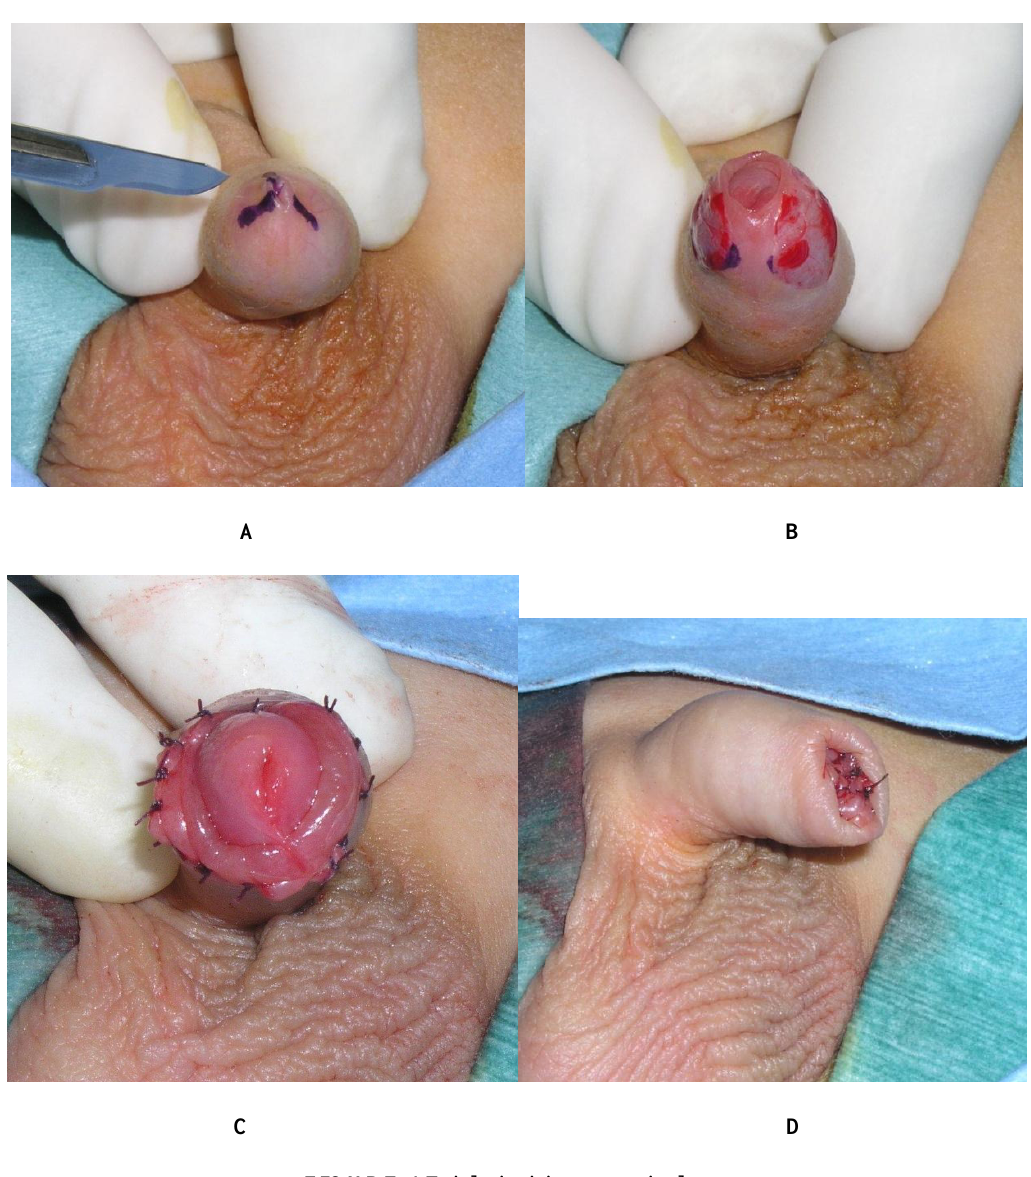
FIGURE 4 .Triple-incision